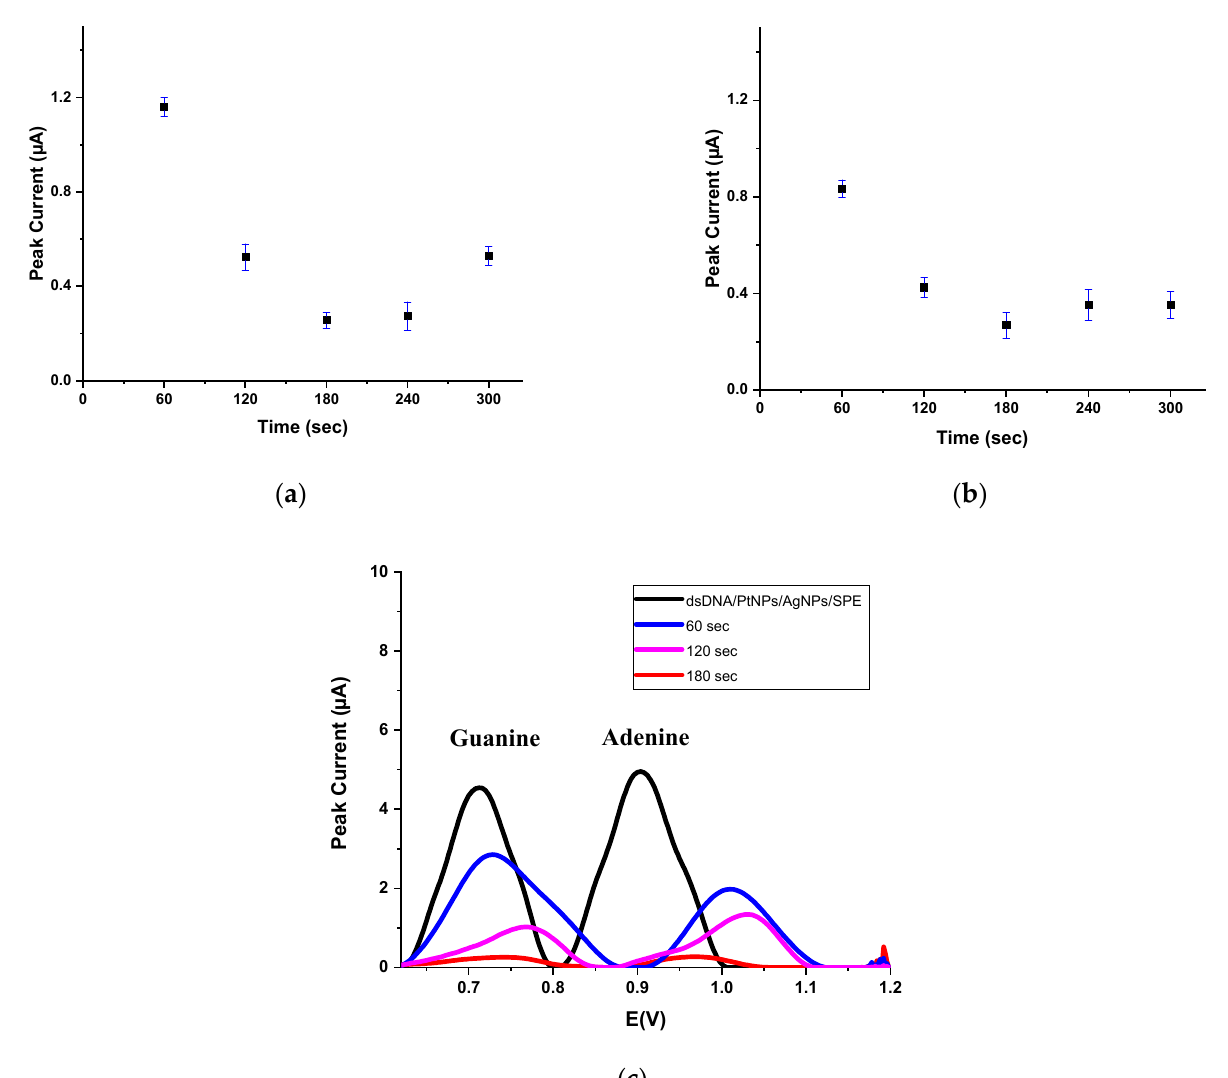
Figure 6. The effect of the binding time of 0.5 ppm IDA on the signal of ( a ) dGuo and ( b ) dAdo ( c ) DP voltammograms of dsDNA/PtNPs/AgNPs/SPE (black) with different binding time of IDA in pH 4.70 AB; 60 s (blue), 120 (pink), 180 s (red).